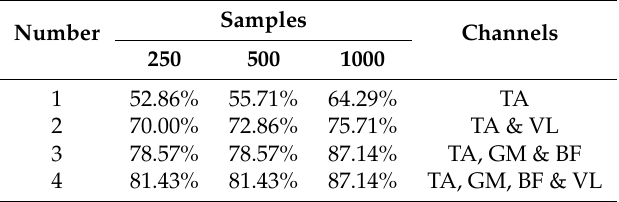
Table 2. Results obtained with the lowest accuracy among the eight subjects.